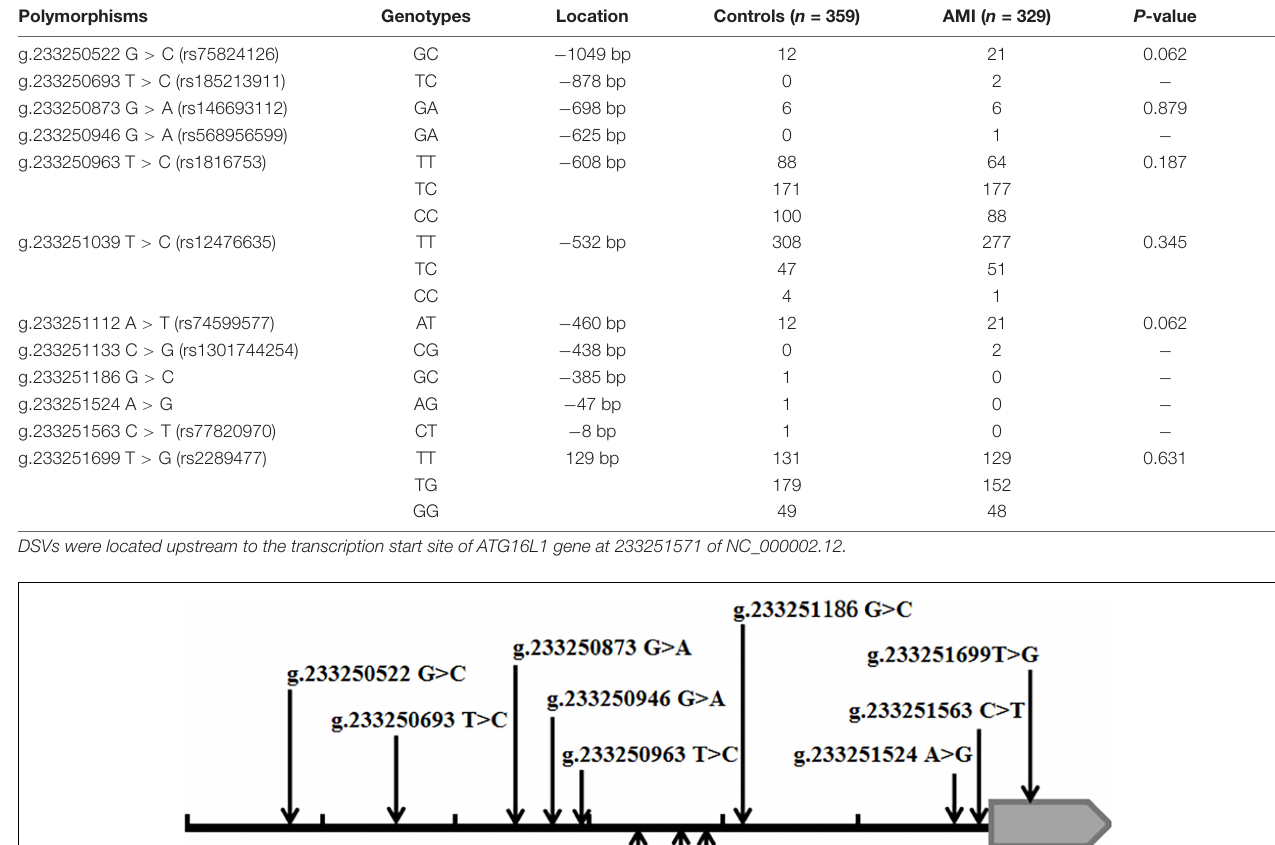
TABLE 3 | DSVs within the ATG16L1 gene promoters in AMI patients and controls.